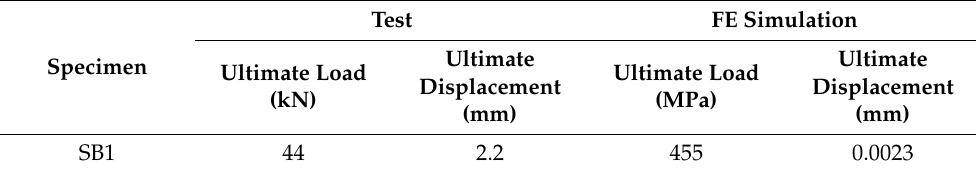
Table 3. Test and FE Results.